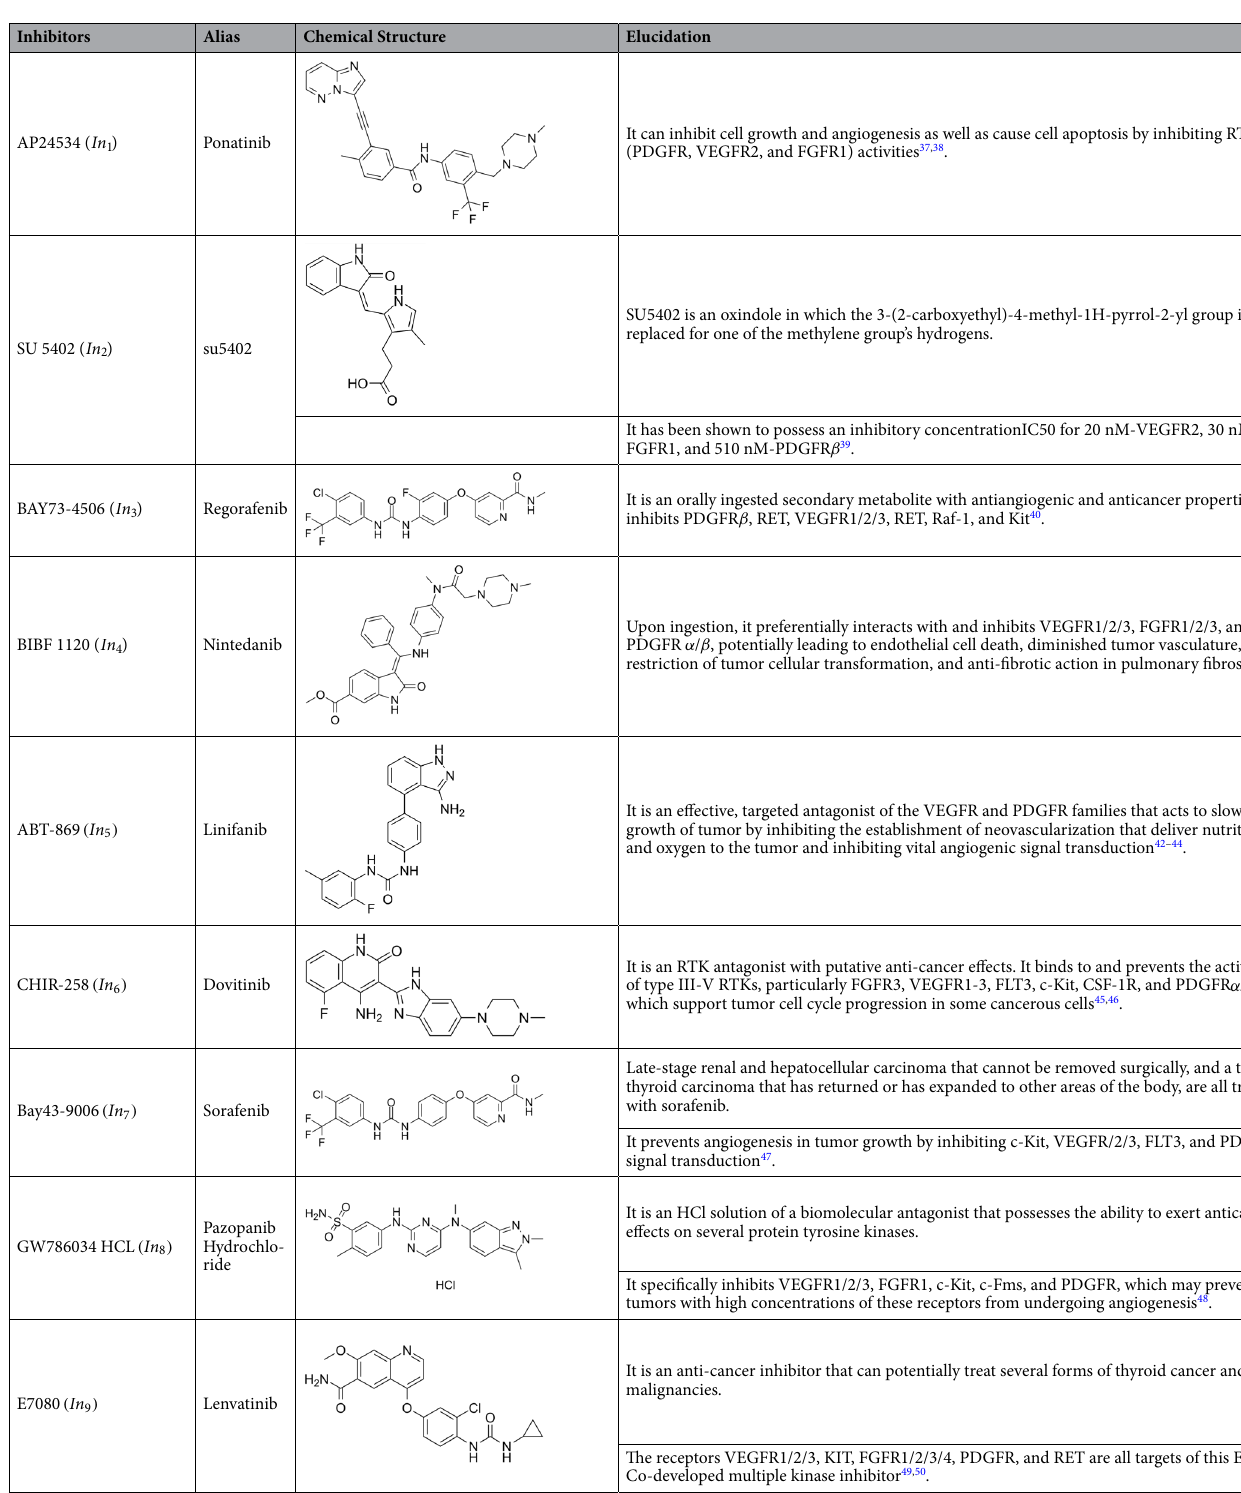
Table 2. Elucidation of Angiogenic Inhibitors along with Chemical